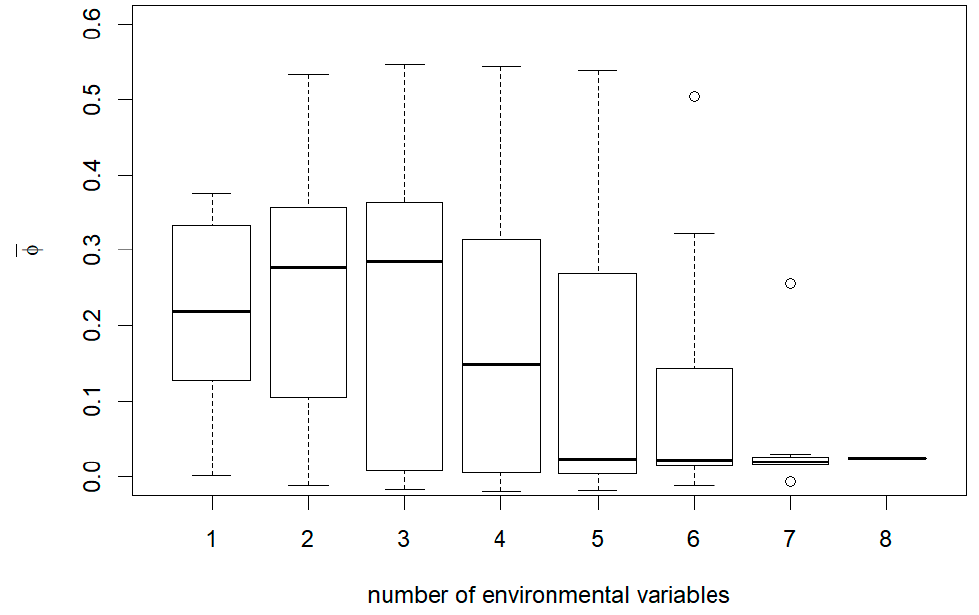
Figure A10. Box plot of mean phi coefficients ( φ ) of the FDMs generated by SVC as affected by the number of explanatory variables. Box plot shows median plus upper and lower quartiles for φ of FDMs with a given number of explanatory variables. Minimum and maximum values are indicated by the upper and lower whiskers (1.5 × interquartile range). Circles are outliers.